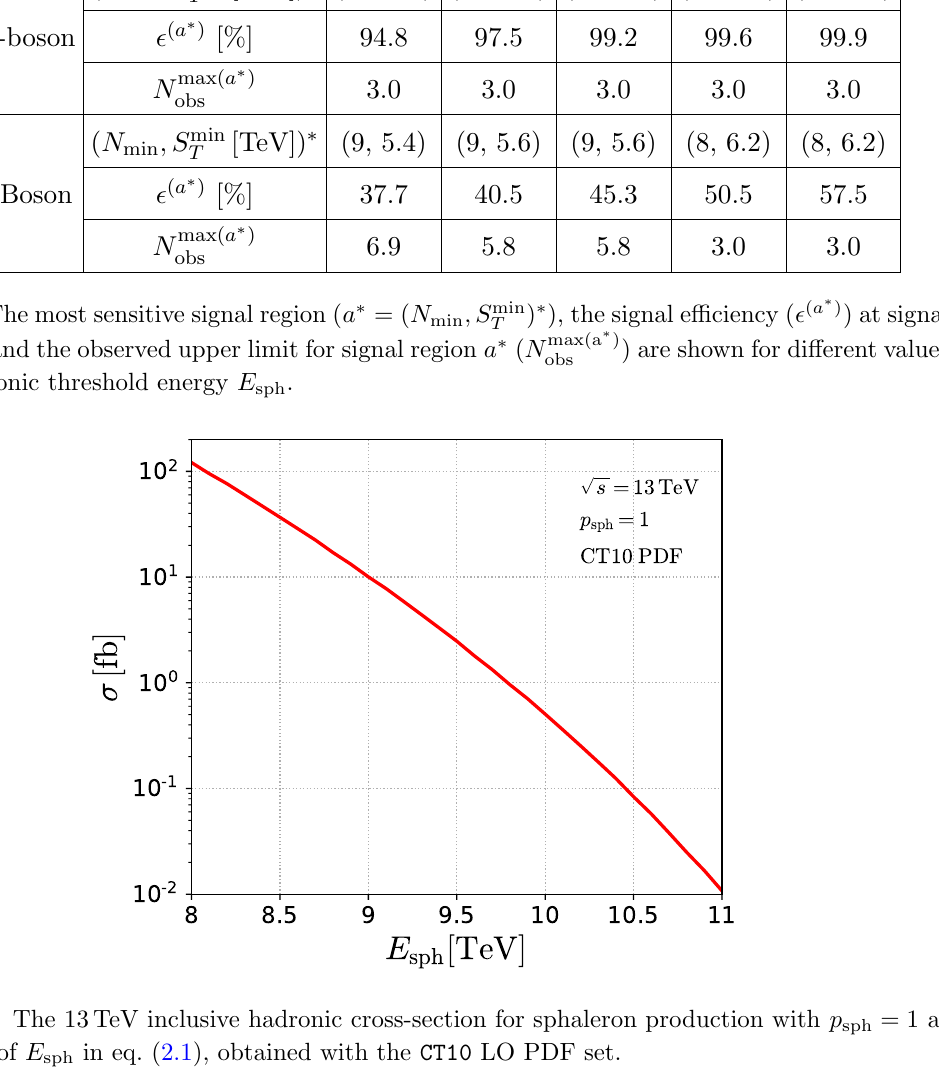
is de(cid:12)ned as the fraction of events that satisfy the condition employed by the signal